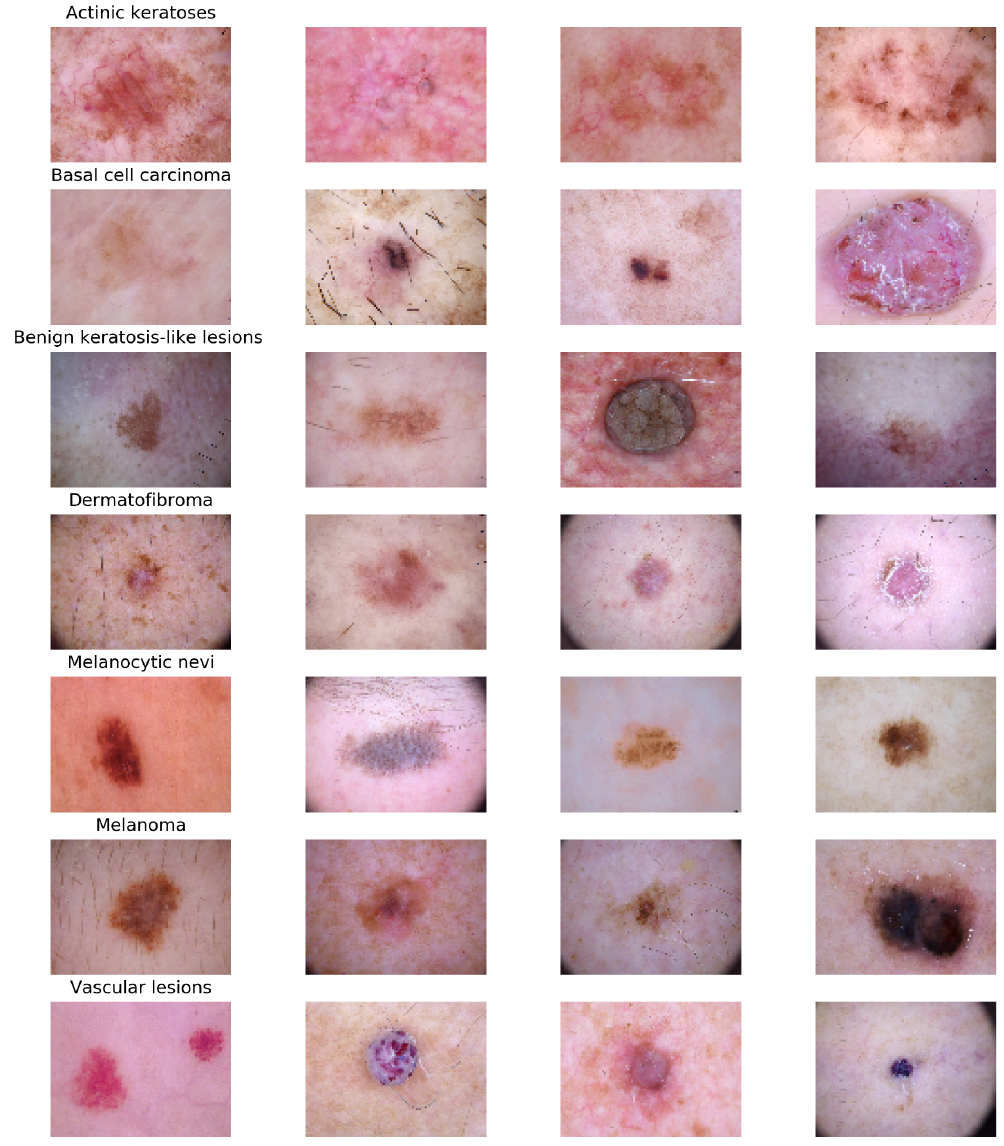
Figure 4. Skin disease samples of 7 classes in skin disease